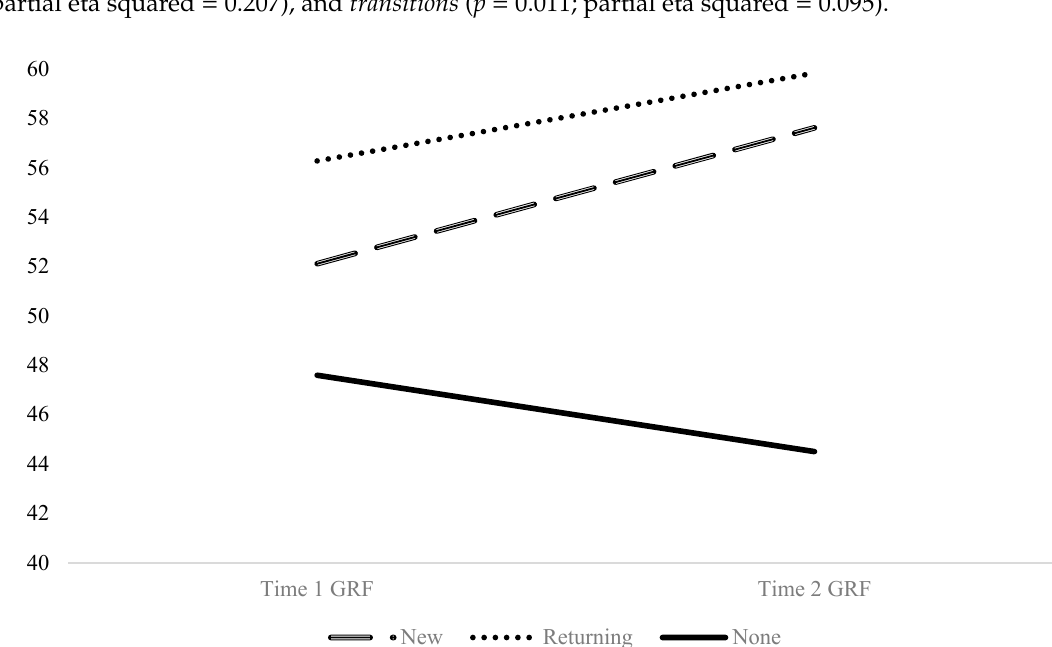
Figure 1. Group by time interaction of Great Recess Framework-Observational Tool (GRF-OT) scores show that recess sessions with Playworks programming increased their GRF-OT score throughout the year, while those with no programming decreased their GRF-OT